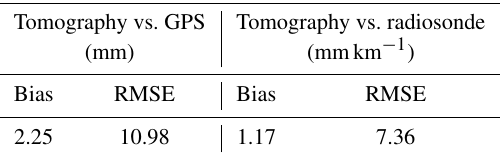
Table 3. Comparison of tomography with GPS and radiosonde mea- surements under conditions of heavy precipitation during May to October 2013. Tomography is carried out using multi-source data with the vertical constraint scheme